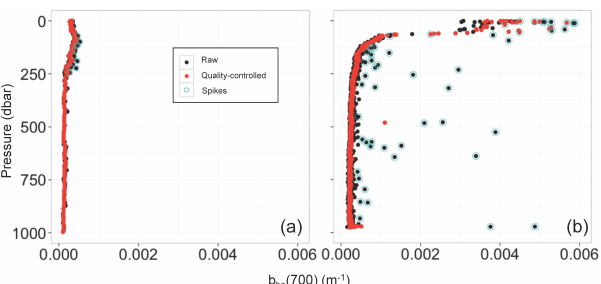
Figure 5. (a, b) Raw (i.e., before positive spike removal) and quality-controlled (i.e., after application of a median filter) vertical profiles of particulate optical backscattering at 700nm ( b bp (700)) collected in the South Atlantic subtropical (float WMO 6901439) and North Atlantic subpolar (float WMO 6901516) gyres, respec- tively. Open cyan circles indicate positive spikes (Briggs et al., 2011).